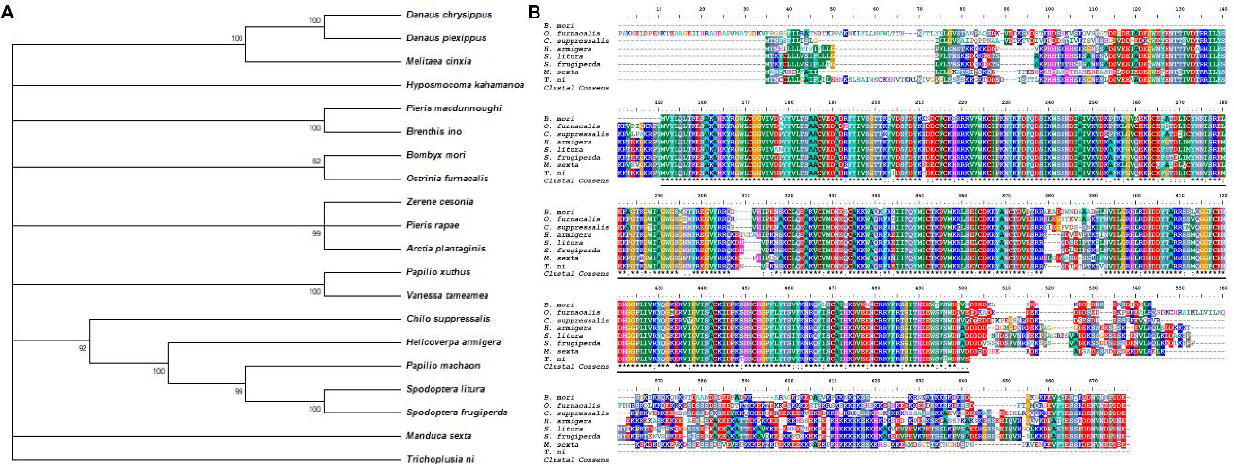
Figure 1. Sfp62 is highly conserved in lepidopterans. ( A ) The phylogenetic tree of Sfp62 in B. mori and other 19 representative lepidopteran species. GenBank accession numbers are as follows: Bombyx mori (XP_021204150.2), Danaus chrysippus (CAG9569287.1), Danaus plexippus (XP_032523373.1),